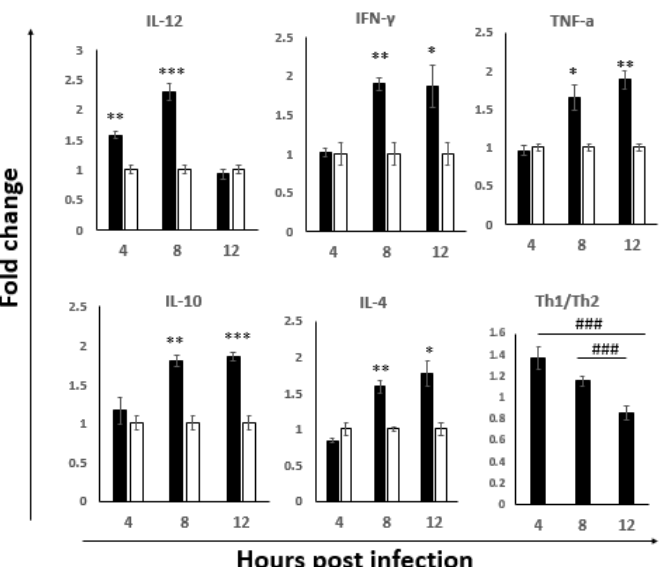
Figure 4. The expression of Th1 and Th2 cytokines in the ILP cells of NN1172-infected birds at early stage of infection. The mRNA expression levels of cytokines in the ILP cells of IBDV infected birds were detected at 4, 8 and 12 hpi. Th1/Th2 bias ratio was calculated as average of each Th1/Th2 cytokine. Results represent mean ± SEM, n = 5, (* p < 0.05; ** p < 0.01; *** p < 0.001) between the infected-group (black bar) and the uninfected-group (white bar). ### p < 0.001 of Th1/Th2 between each time point post IBDV infection.